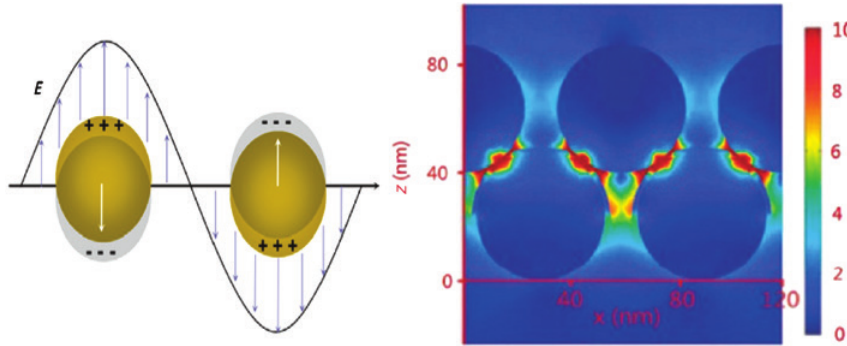
Figure 9: Sketch of the mechanism of laser irradiation to gold or sliver nanostructured surfaces. The left image shows local surface plasmas caused by collective oscillations of charge on the surface of metal nanoparticles [47]. The right image is the distribution of the EM field intensity, which is simulated by the finite element method